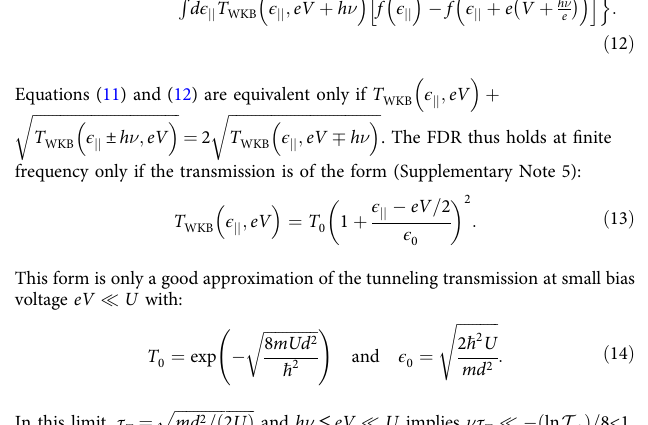
In this limit, τ T =